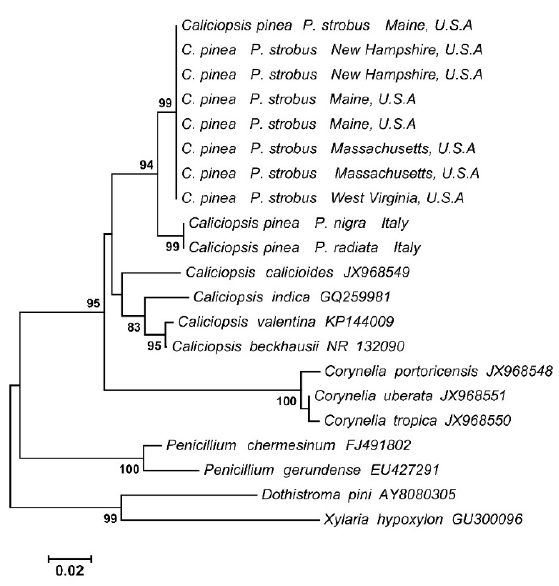
Figure 3. Neighbor-joining phylogenetic tree based on the ITS sequence of fungi isolated from Caliciopsis pinea fruiting bodies or infected plant tissue, as well as closely related species imported from Genbank or provided by collaborators. C. pinea isolates are followed by host species and location the isolate was recovered from. Remaining isolates are followed by their respective Genbank accession numbers. Bootstrap values >70% were included at the